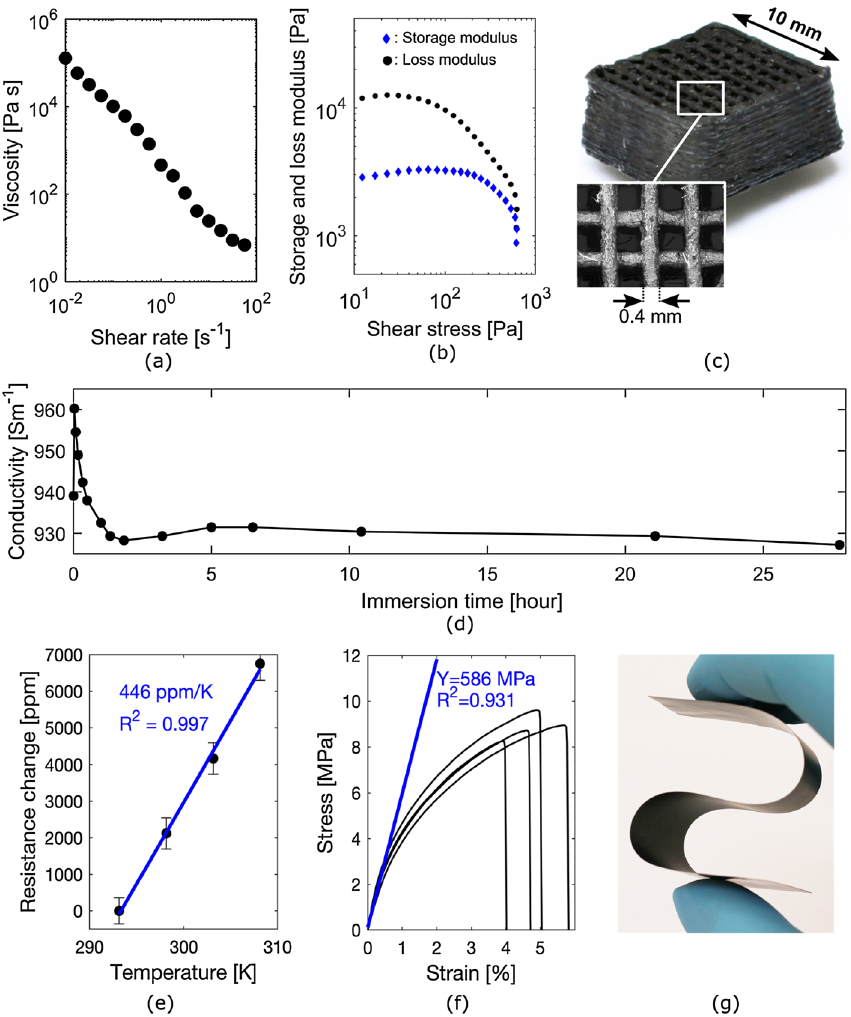
Figure 2. (a) Graph of the ink’s viscosity as a function of shear rate showing shear-thinning behavior. (b) Graph of the ink’s storage (G’) and loss (G’’) modulus as function of shear stress showing it acts as a solid gel (G’ > G’’) at low shear stress and a fluid (G’ < G’’) above its yield stress of 600 Pa. (c) Photograph of an electrically conductive 3D scaffold structure printed by robocasting using our ink. (d) Graph of the electrical conductivity of our ink as a function of immersion time in water showing stable performance over more than 27 h of continuous immersion. (e) Graph of the resistance change as function of temperature averaged over five temperature cycles. The linear fit gives a 446 ± 74 ppm/K temperature coefficient of resistance (TCR). (f) Four stress–strain curves measured on self-standing films of our ink. The linear fit gives an average Young’s modulus of Y = 586 ± 37 MPa and indicates plastic deformation above 1% strain. (g) Photograph of an electrically conductive, self-standing and flexible film of our